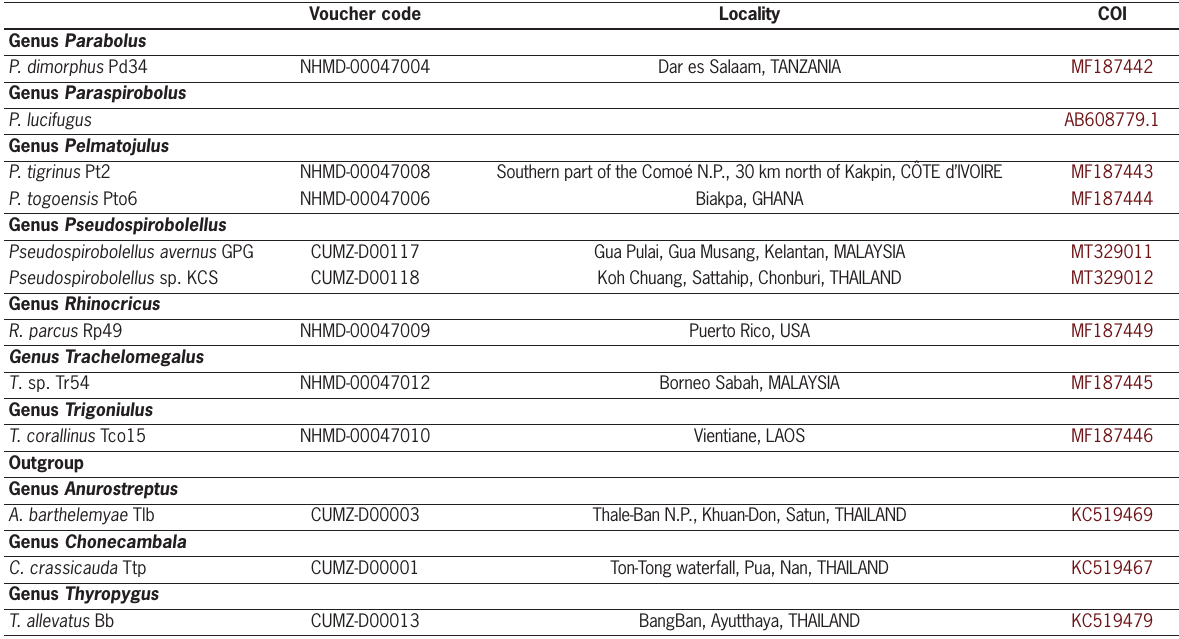
conis gen. et sp. nov. and Siliquobolellus constrictus gen. et sp. nov. Diagnosis. Siliquobolellus species are characterised by (1) the unique shape of the telopodital part of their posterior gonopod, which forms a deep concavity. In contrast, the telopodital part of the posterior gonopod is extremely slender and sickle-shaped in Pseudospirobolellus , does not form a deep concavity in Coxobolellus , or is slender with a broad apical canopy in Benoitolus ; (2) the telopodite of anterior gonopod (at) simple, directed distad, not reaching tip of coxal part of the anterior gonopod (cx). In contrast, the telopodite of anterior gonopod (at) is overreaching coxa in the other three genera; and (3) tip of anterior gonopod coxa narrowed, curving mesad. In contrast the tip of the anterior gonopod coxa directed distad in Coxobolellus , or is rounded in Pseudospirobolellus and Benoitolus . General description. Head capsule smooth. Occipital furrow extending down between, but not beyond eyes; clypeal furrow reaching level of antennal sockets. Area below antennal sockets and eyes impressed, forming part of antennal furrow. Incisura lateralis (IL) open (Fig. 2A). 2+2 labral teeth, a row of labral setae, 3+3 supralabral setae. Diameter of eyes ca half of interocular space; 7 vertical rows of ommatidia, 4 horizontal rows, 24–26 ommatidia per eye. Antennae short, not reaching beyond collum when stretched back, accommodated in a shallow furrow composed of a horizontal segment in the head capsule and a vertical segment in the mandibular cardo and stipes. Antennomere lengths 2 > 6 > 1 > 5 > 3 = 4 > 7 in Siliquobolellus amicusdraconis gen. et sp. nov. and S. constrictus gen. et sp. nov. and 2 > 1 > 6 > 5 > 3 = 4 > 7 in S. prasankokae gen. et sp. nov.; antennomere 1 glabrous, 2 and 3 with some ventral setae, 4, 5 and 6 densely setose; 4 apical sensilla. Mandibles: stipes